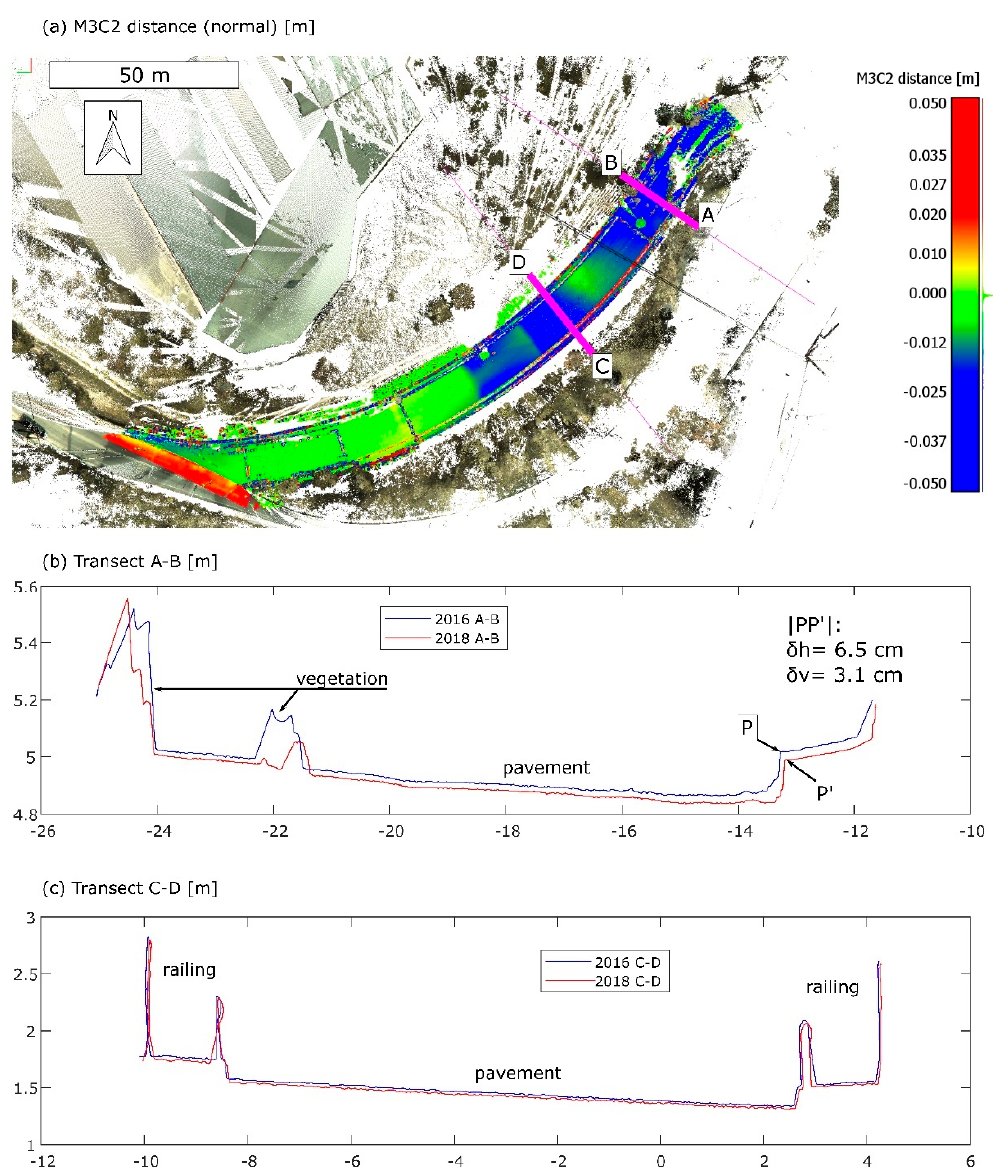
Figure 9. ( a ) Comparison of LiDAR models between May 2016 and April 2018 and location of the extracted steepest slope transects; ( b , c ) transects of the 3D point cloud of stages 2016 and 2018.